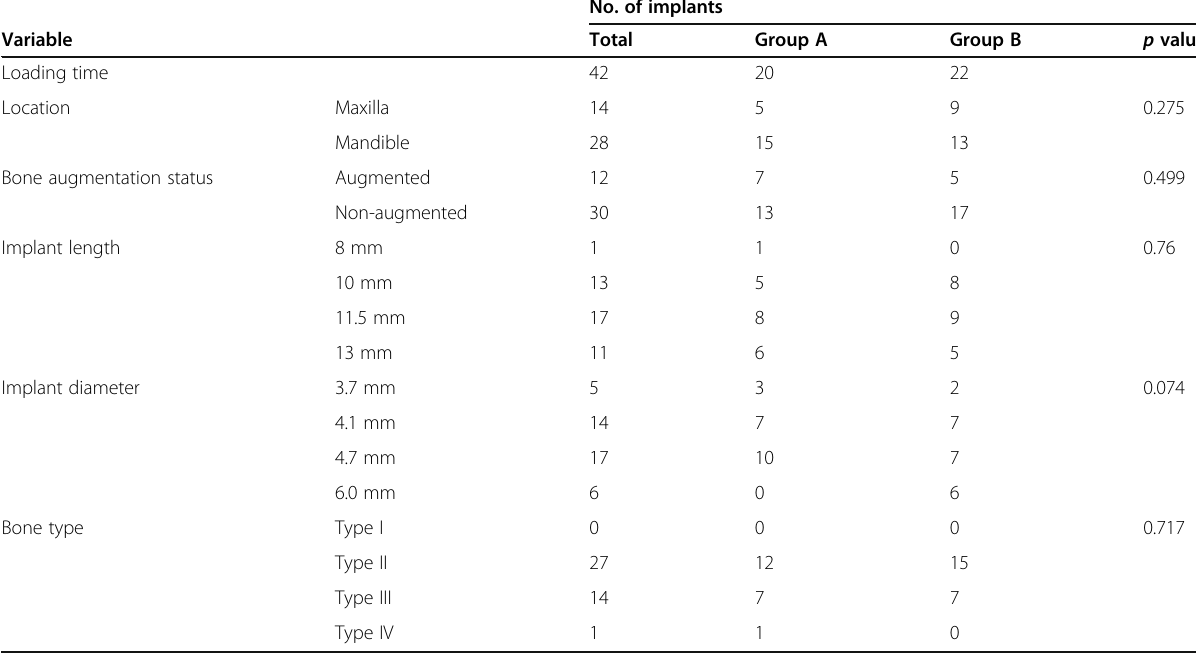
Table 2 Implant-related variables by treatment